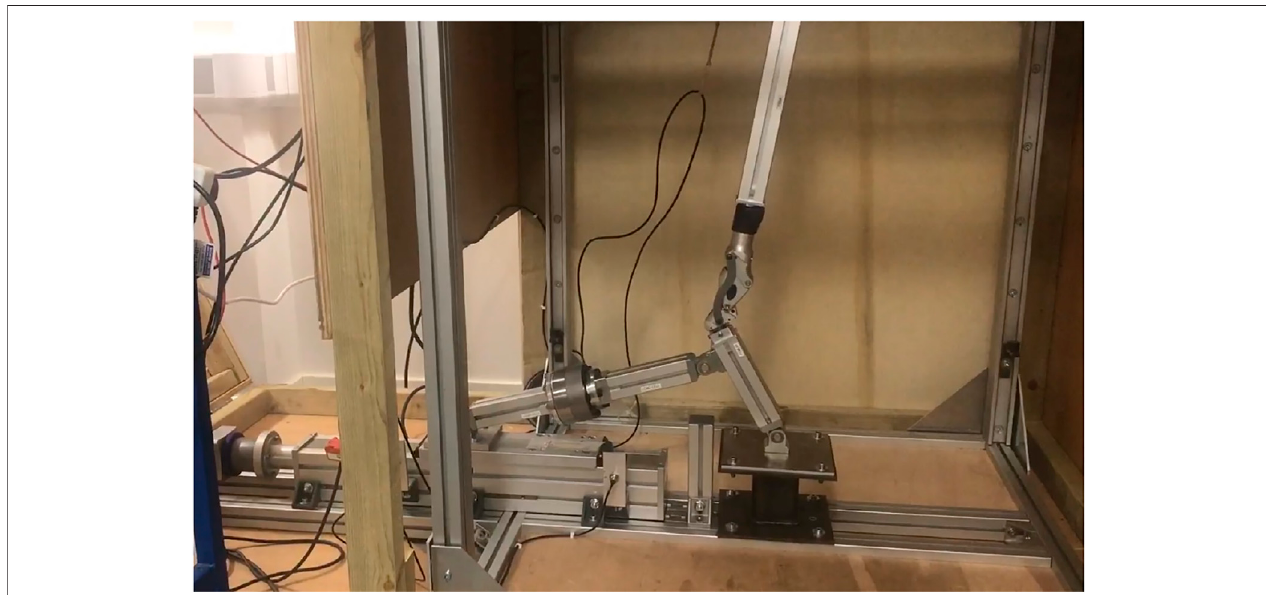
FIGURE 6 | Actual test rig in motion with an Ottobock 3R106 joint (Dobner).